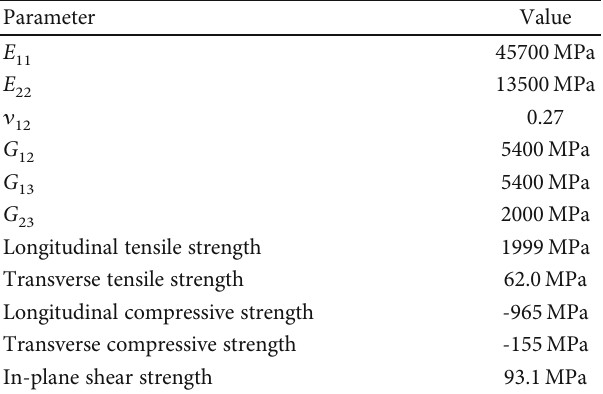
Table 3: Glass- fi bre reinforced polymer mechanical properties.